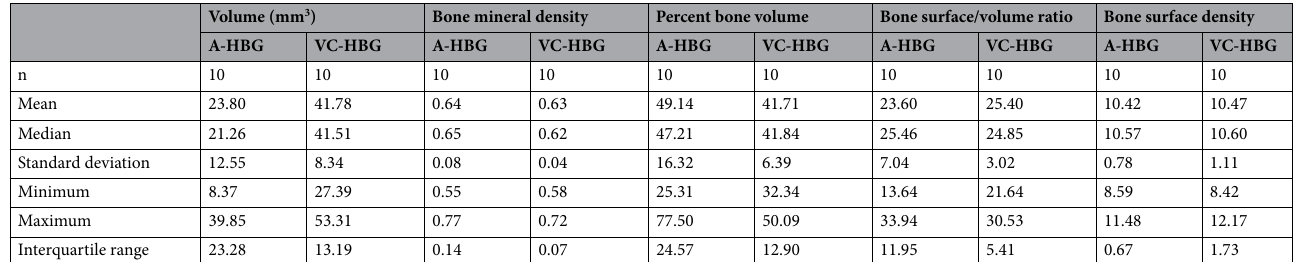
Table 1. Descriptive analysis of tomographic quantitative variables by type of graft. A-HBG acellular-human bone graft, VC-HBG viable cryopreserved-human bone